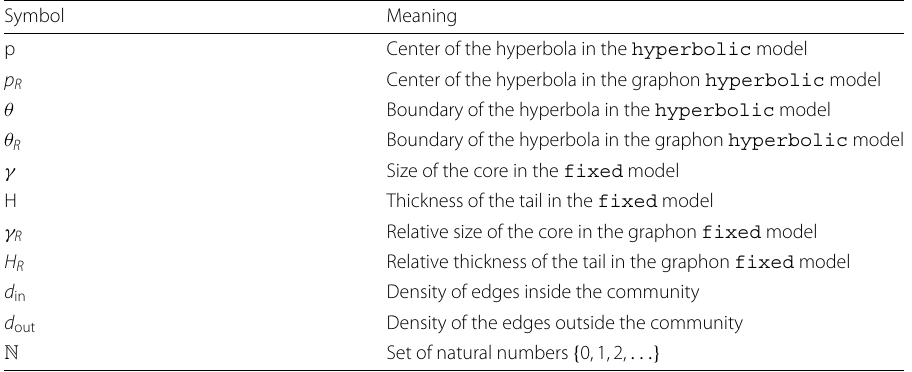
Table 1 List of